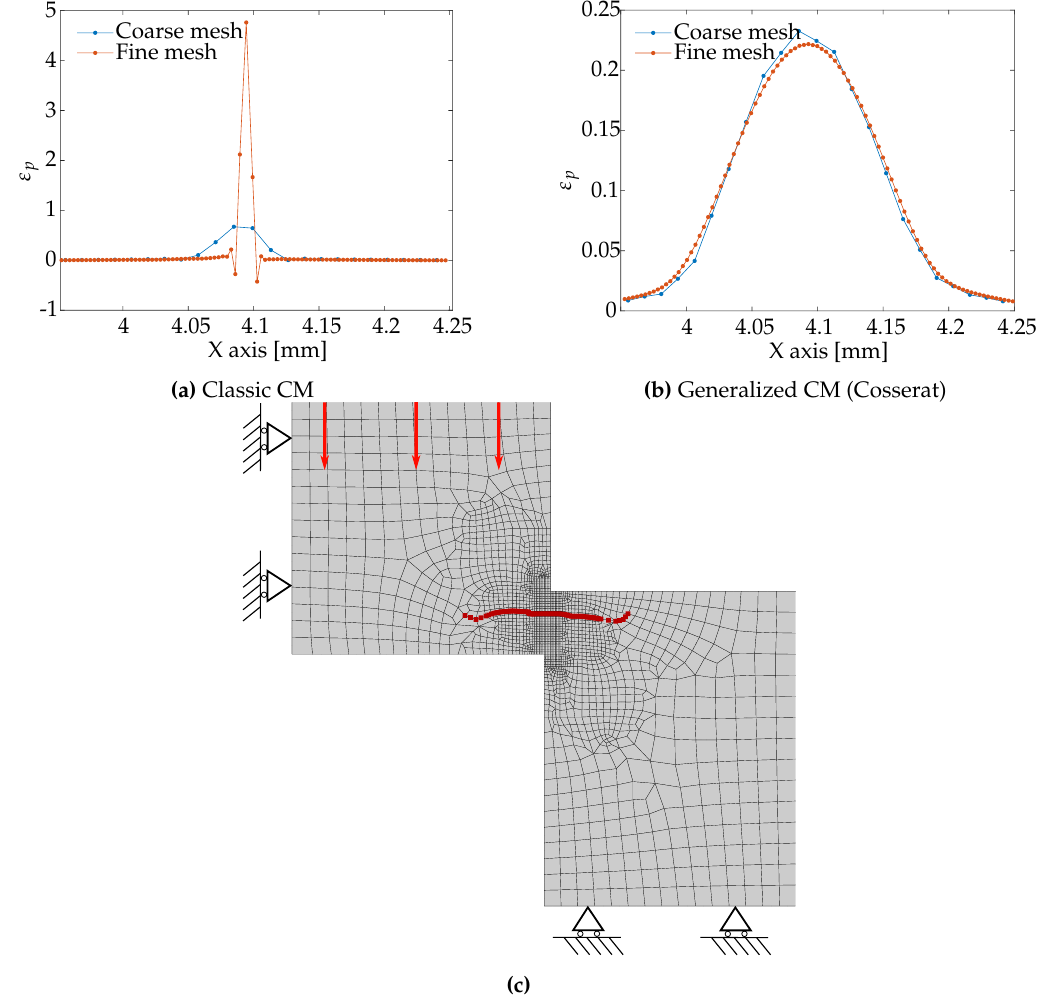
Figure 5. Mesh hypersensitivity demonstrated through compression simulation on a Hat-Specimen [65]. Distribution of equivalent plastic strain obtained for different mesh sizes using the Classical CM ( a ). Distribution of equivalent plastic strain in case a Generalized CM (Cosserat Medium) is used ( b ). Boundary conditions and geometry of the axial-symmetric cross section of the Hat-Specimen used for simulation ( c ). The red line in ( c ) indicates the location where the equivalent plastic strain was